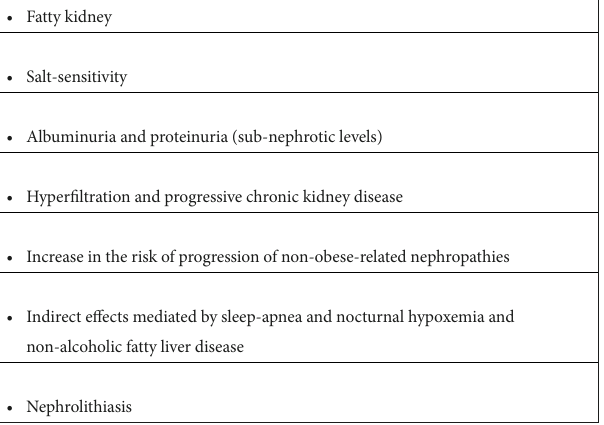
TABLE 1 Clinical consequences of obesity in the